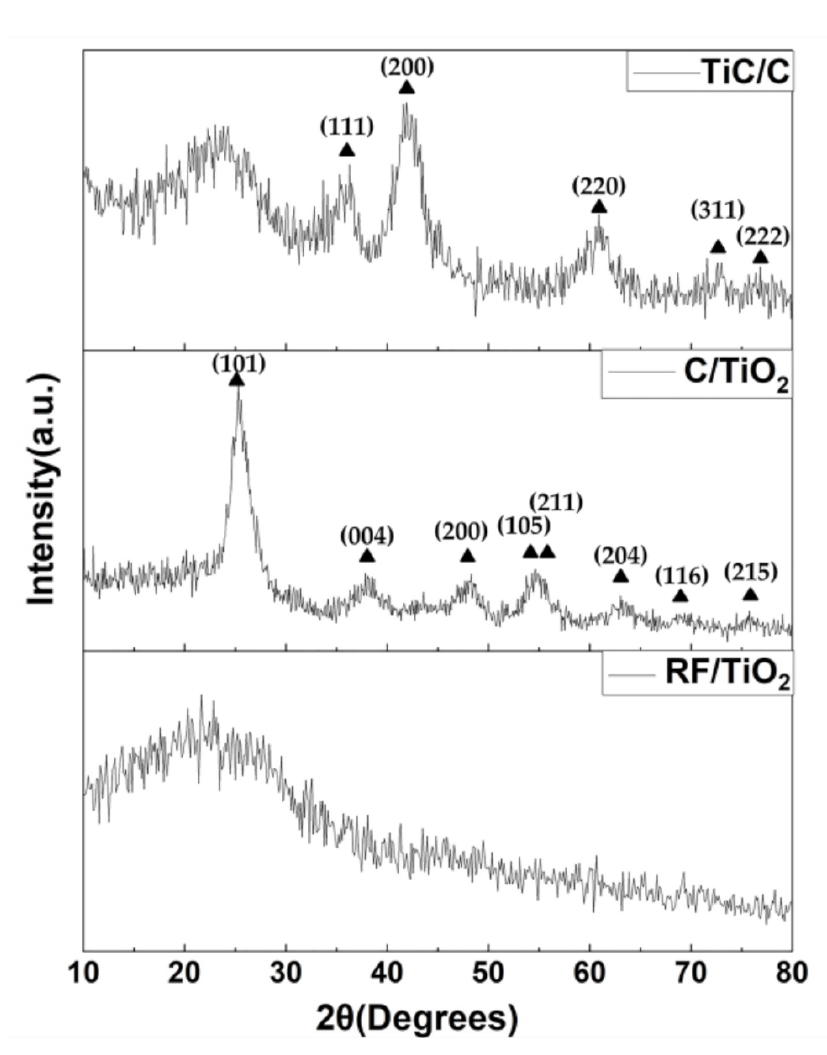
Figure 2. XRD spectra of RF / TiO 2 aerogel, C / TiO 2 aerogel and the objective product TiC / C